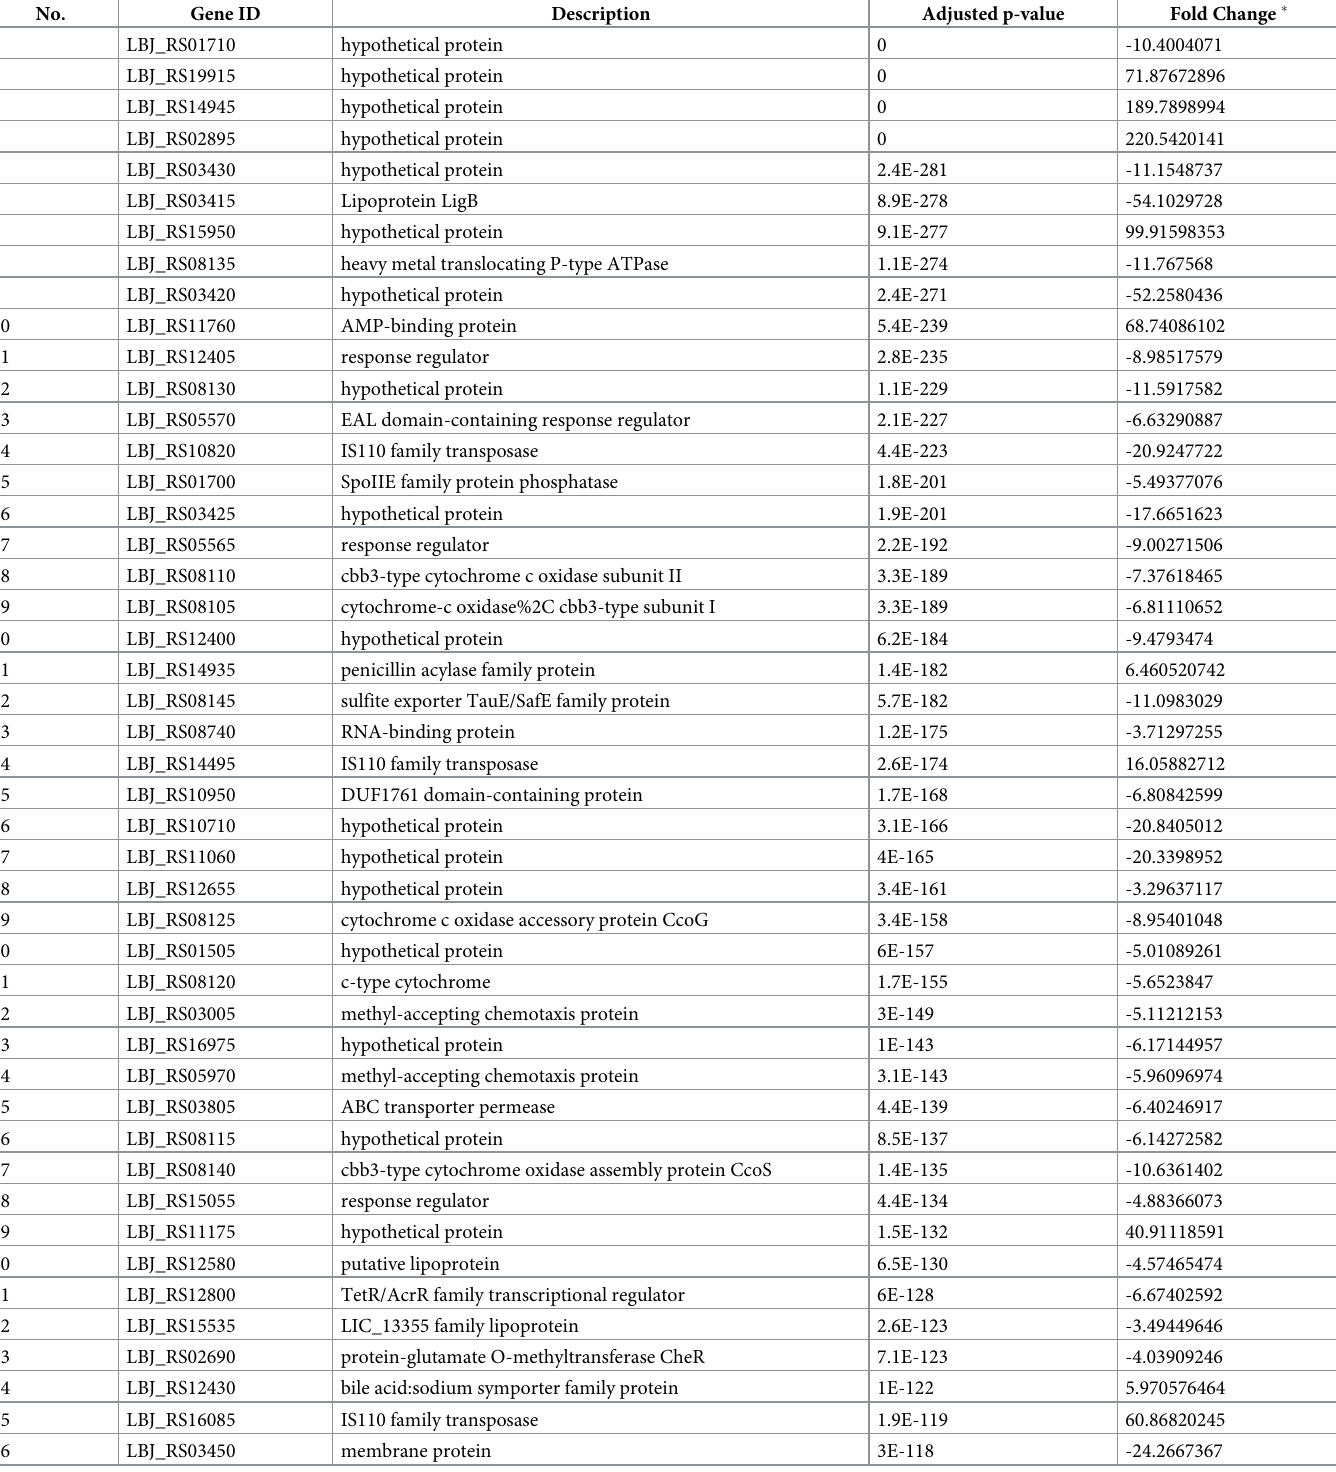
Table 2. The fifty most significantly differentially expressed genes between JB197 and HB203 grown at 29˚C. All genes are relative to the JB197 reference genome and annotated by the JB197 gene ID. � Positive fold change values denote higher transcription in JB197 and conversely, negative values indicate higher expression in HB203.